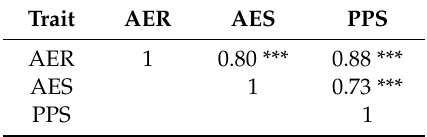
Table 4. Analysis of the relationship between AER, AES and